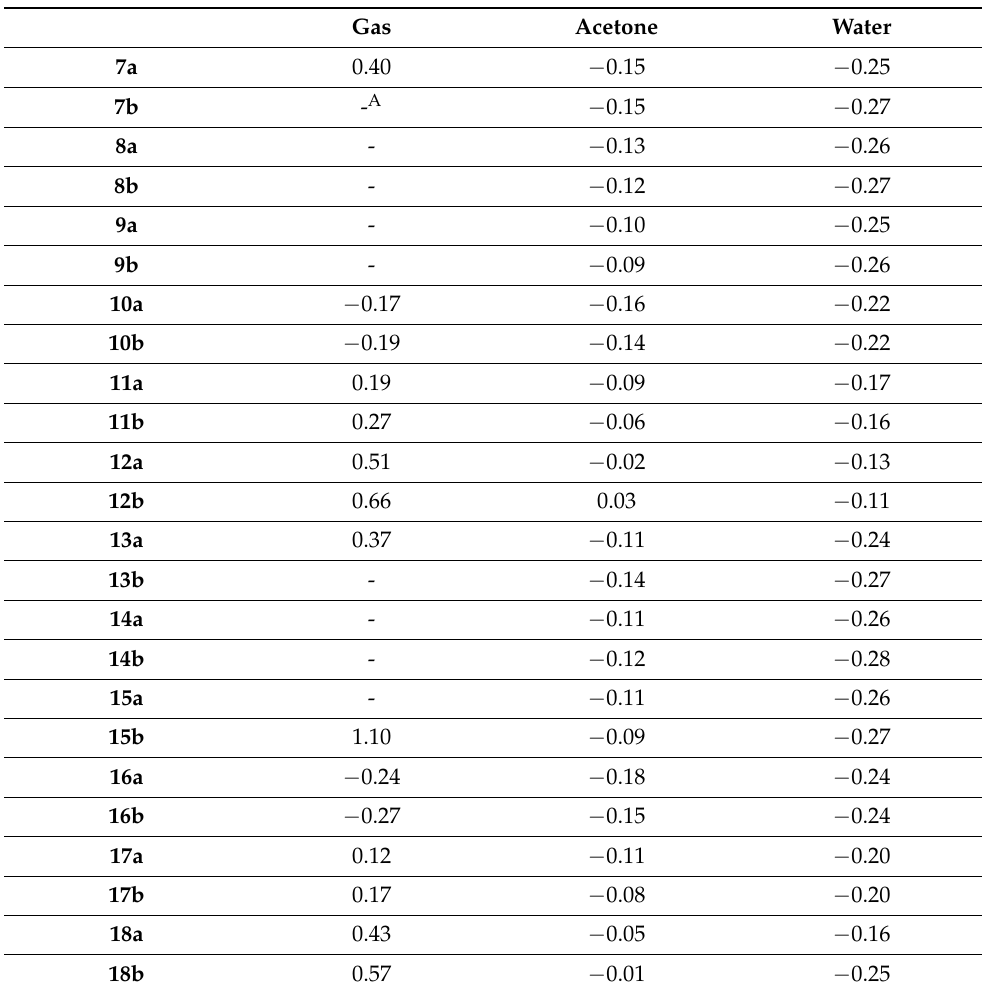
Table 6. Interaction energies (kcal/mol) of chalcogen bonded dimers calculated at the MP2/aug-cc- pVDZ. Values corrected for BSSE.